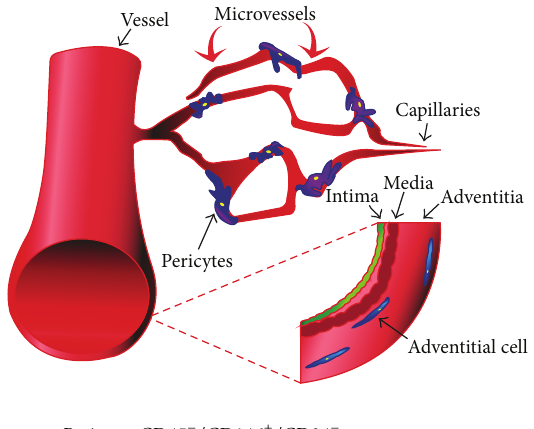
Figure 1: Pericytes and adventitial cells associated with skeletal muscle microvessels. A scheme showing the MSC subpopulations present in the three structural layers of blood vessels: pericytes (green) from media, adventitial cells (yellow) from adventitia, and myogenic endothelial cells from intima. Illustration of the pheno- type of the corresponding cells: pericytes (CD45 − /CD146 + /CD34 − ) and adventitial cells (CD45 − /CD146 − /CD34 +